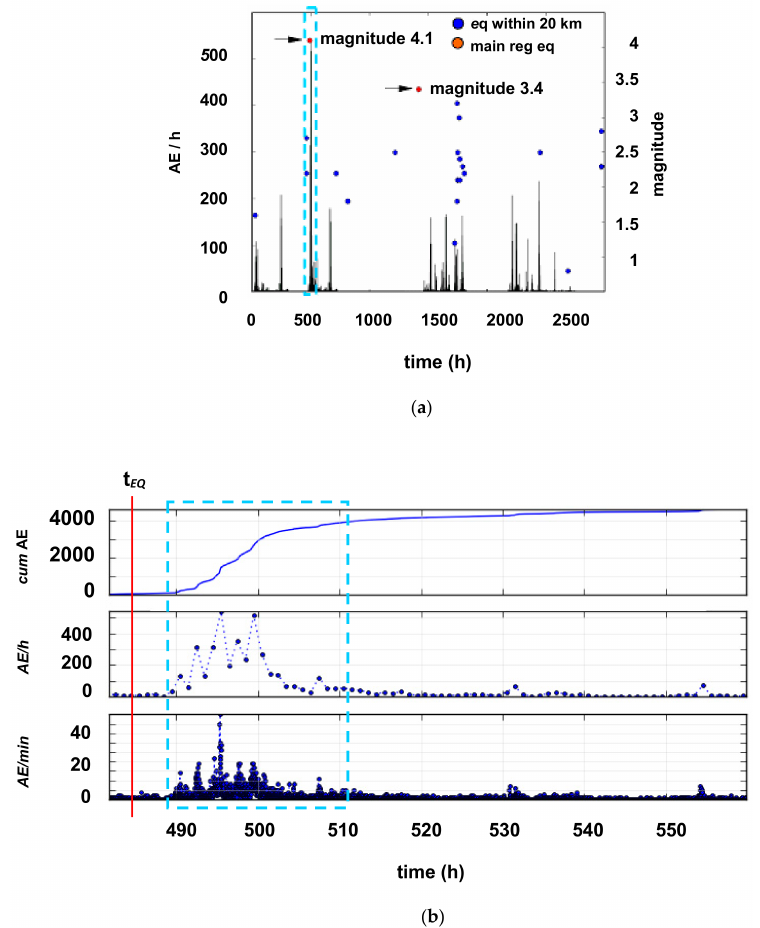
Figure 2. ( a ) Time series of the AE signals count rate and nearby earthquakes (extracted from http: //www.ingv.it/it/, see Supplementary Materials) printed from [28]; ( b ) Expansion of the dashed frame: the red line marks the occurrence time t EQ = 486 h of 13 October; earthquake